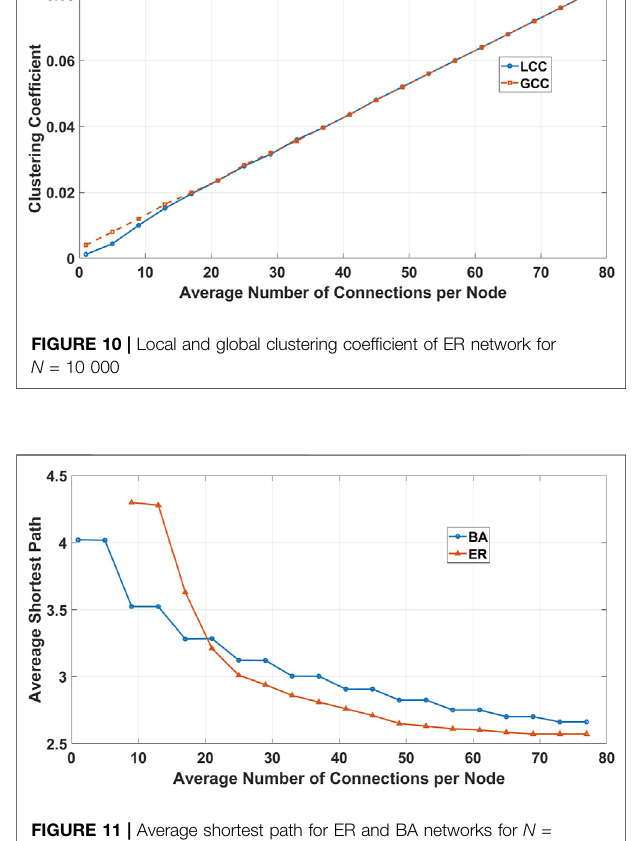
Frontiers in Blockchain |